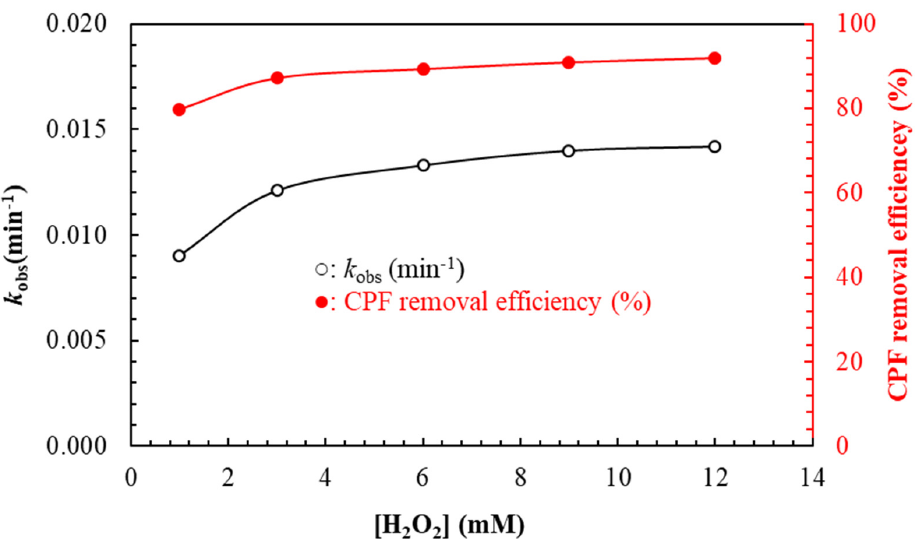
Figure 10. The effects of H 2 O 2 concentration on k obs (min − 1 ) and CPF removal efficiency (%) observed in the solar light-assisted oxidative degradation of CPF catalyzed by Fe III -CS-GLA in aqueous solu- tion. Experimental conditions: [CPF] 0 : 50 µM, [Fe ӀӀӀ ] 0 in Fe III -CS-GLA: 1.25 mM; [GLA] 0 in Fe III -CS- GLA: 90 mM; [H 2 O 2 ] 0 : 1–12 mM; volume of CPF solution: 250 mL; pH: 3; light intensity: 70,000–90,000 Lux; solar light irradiation time: 180 min.